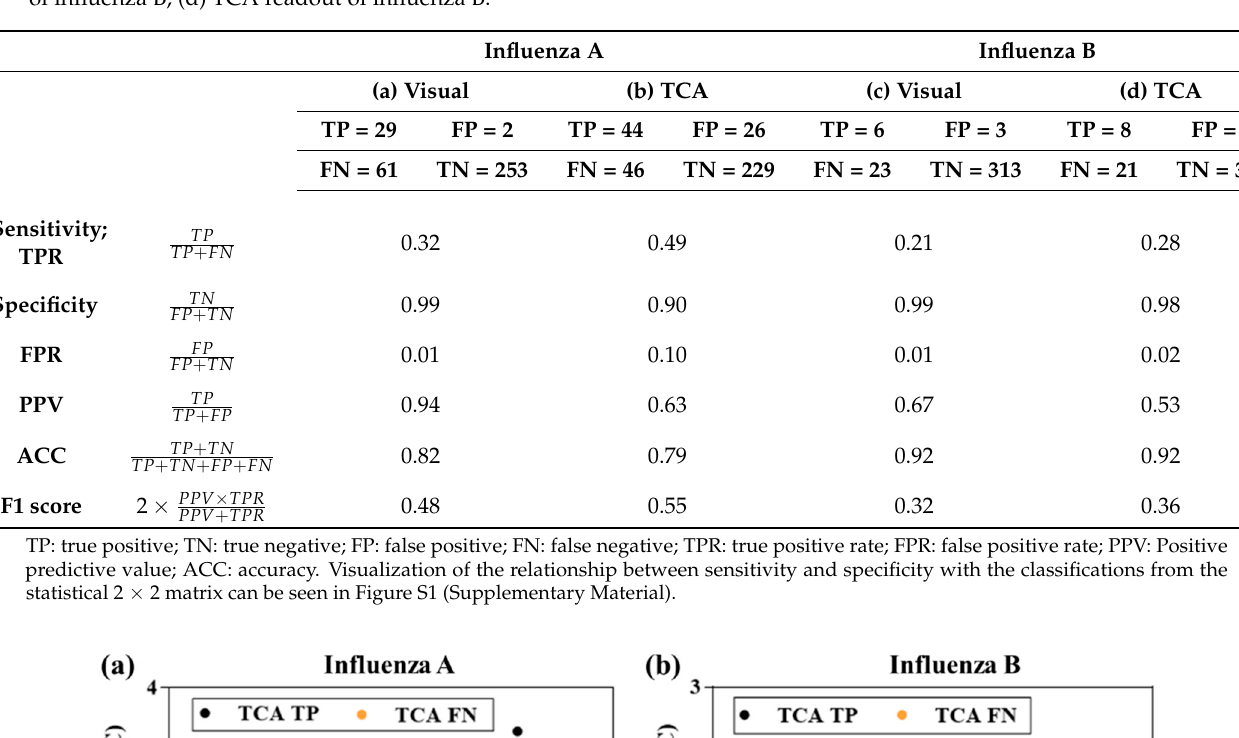
Figure 3. Distribution of thermal contrast signals for influenza A and B. Samples were randomly chosen from 345 clinical LFAs. TP: true positive; TN: true negative; FP: false positive; FN: false negative.